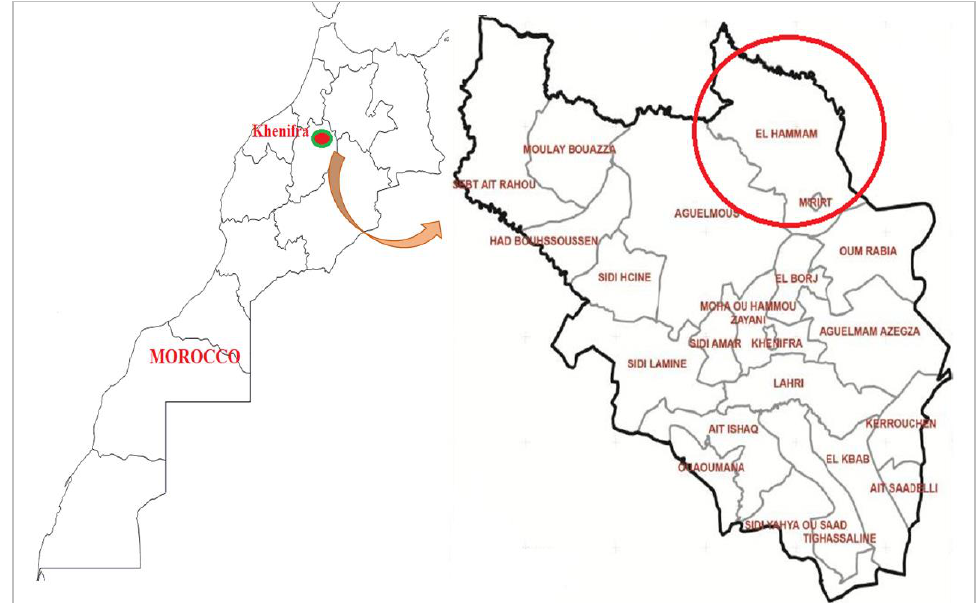
Figure 5. Collection site of the studied plants.